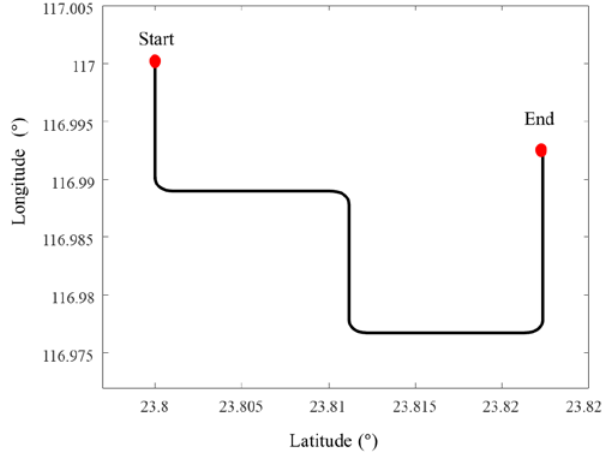
Figure 5. Motion trajectory of AUV.